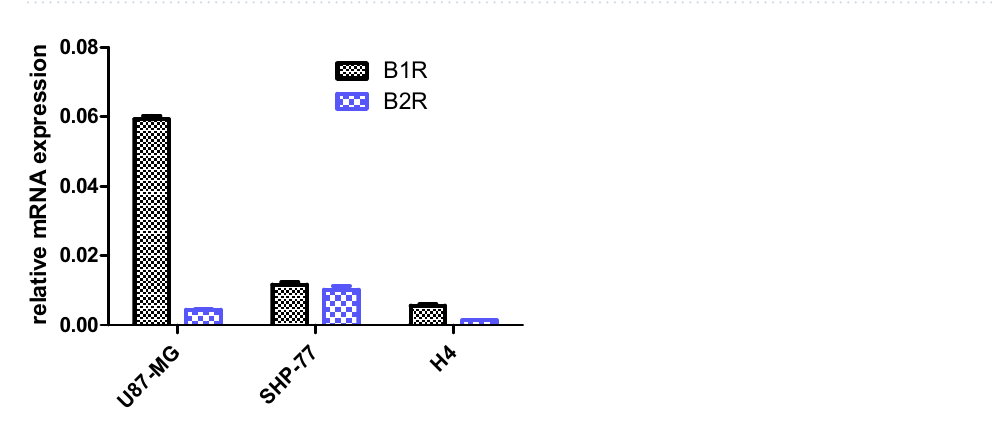
Figure 3. The pharmacodynamic effects of compounds showing inhibitory activity in the B1R screening assay. R892, the B1R antagonist, was used as the reference compound (blue line).